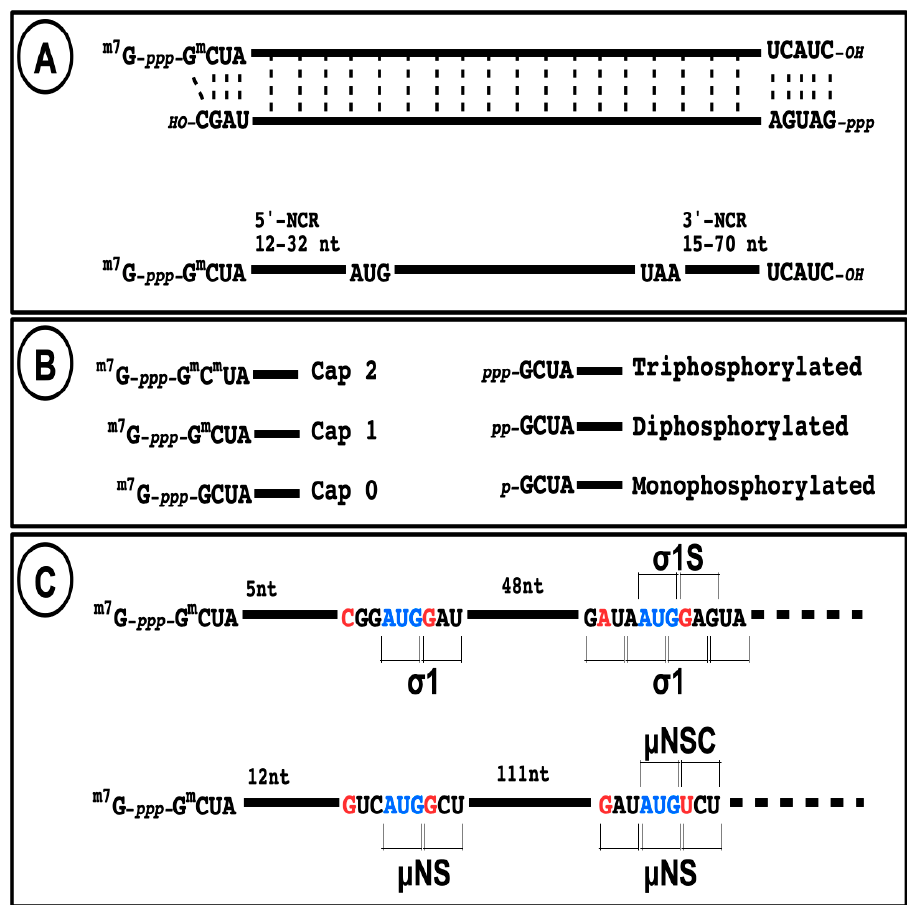
Figure 3. Structure of reovirus RNA. ( A ) The structure of a viral dsRNA genome segment is presented with the different 5’ and 3’-terminal structure and conserved sequences at both ends, as observed for mammalian orthoreoviruses. The structure of a typical mRNA is presented with the length of both 5’ and 3’ non-coding regions. (B) Schematic representation of the different possible capped and uncapped 5’-end on mRNA. ( C ) Schematic representation and nucleotide sequence at the two translational initiation sites on s1 and m3 mRNAs.